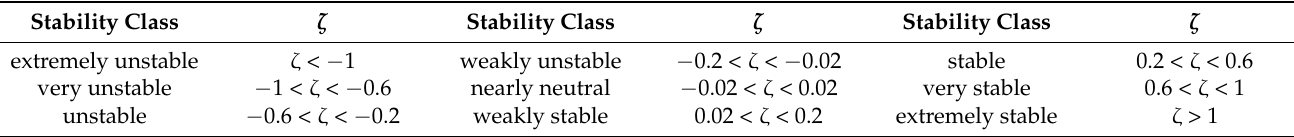
Figure 5. The percentage of occurrence of the dimensionless stability parameter ζ = z/L ( a ) at the tower over sea, ( b ) at the tower on the island, and ( c ) at the tower on land. The value of z/L < − 1 indicates extremely unstable; − 1 < 𝑧/𝐿 < − 0.6, very unstable; − 0.6 < 𝑧/𝐿 < − 0.2, unstable; − 0.2 < 𝑧/𝐿 < − 0.02, weakly unstable; − 0.02 < 𝑧/𝐿 < 0.02, nearly neutral; 0.02 < 𝑧/𝐿 < 0.2, weakly stable; 0.2 < 𝑧/𝐿 < 0.6, stable; 0.6 < 𝑧/𝐿 < 1, very stable; 𝑧/𝐿 > 1, extremely stable. Table 2. Stability classification method same as Sorbjan and Grachev [28].